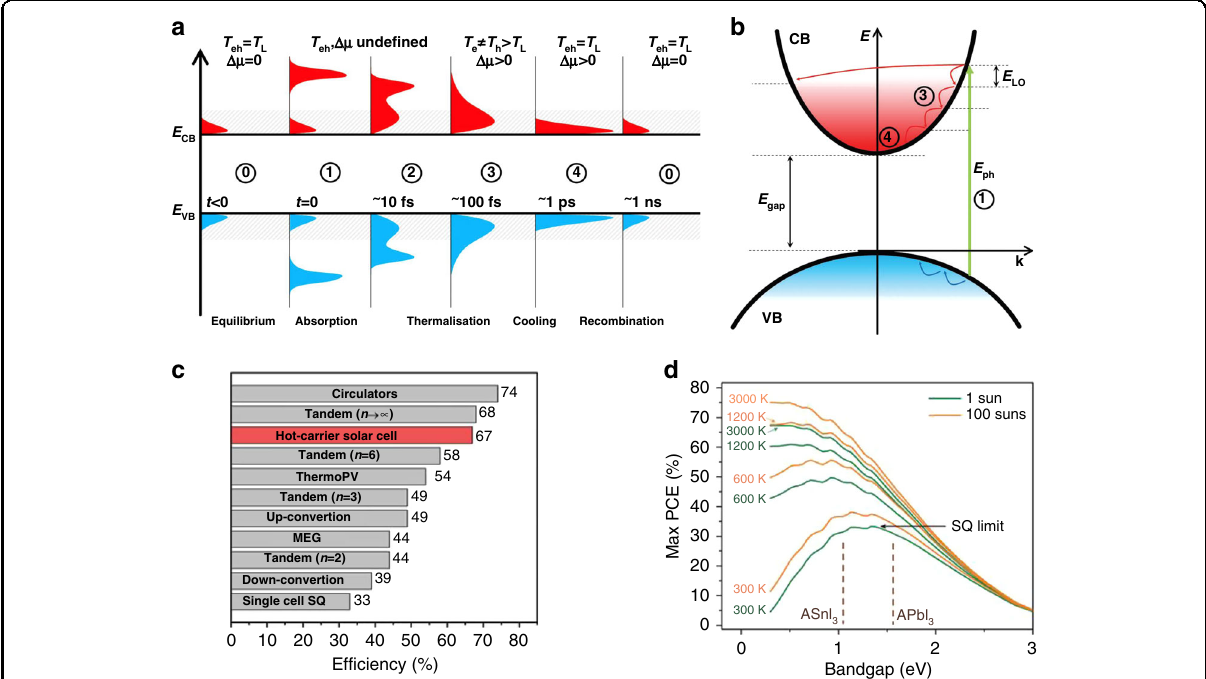
Fig. 2 The schematics represent an arbitrary narrow bandgap semiconductor with the distribution of charge carriers in the two energy bands (VB and CB) and ef fi ciencies of various new generation solar cells which crosses the S-Q limit. a The sequential process of HC, starting from excitation till recombination. b The cooling of HC in their respective bands of unequal curvatures (as different carrier effective mass). c The new generation solar cells with ef fi ciency above the S – Q limit. d Under irradiation of 1 and 100 suns concentration (i.e., low-concentrator photovoltaics) the ultimate ef fi ciency of HC solar cells, at different charge carrier temperatures, plotted versus their photoabsorber bandgap. A conventional solar cell is represented by the lowermost curve, while the vertical dashed lines correspond to the bandgap of halide perovskite materials. “ A ” in ASnI 3 and APbI 3 corresponds to methylammonium (MA), formamidinium (FA), and cesium (Cs) ions. The fi gures are adopted with permission from ( a , b ) ref. 14 and ( c , d ) ref.